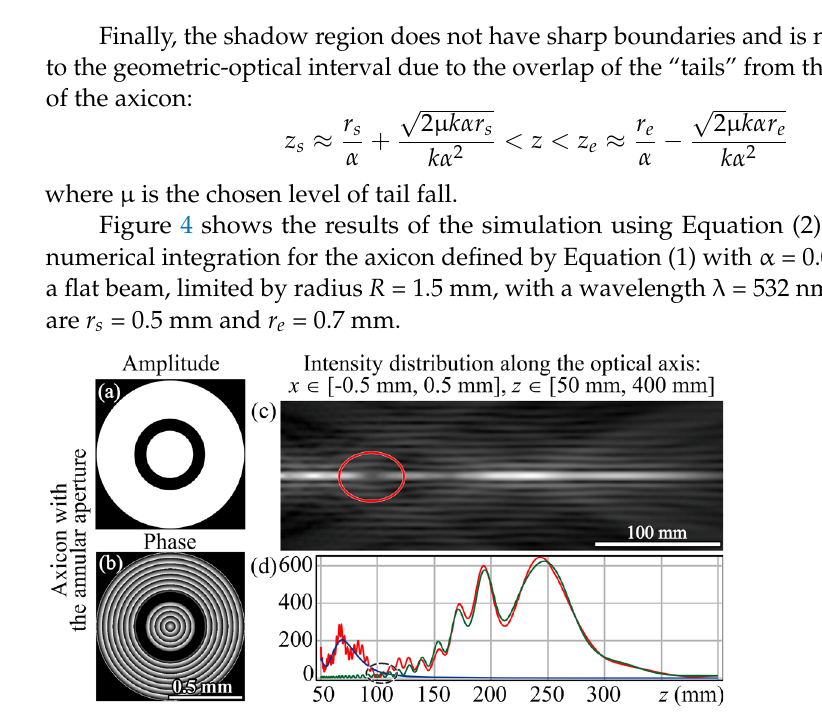
Figure 4. Simulation results of the optical bottle formation by blocking radiation using an annular screen under illumination with a flat beam: ( a ) amplitude and ( b ) phase at the input, ( c ) amplitude distribution along the optical axis ( x ∈ [ − 0.5 mm; 0.5 mm], z ∈ [50 mm; 400 mm]), ( d ) plot of intensity on the axis for the annular slots r s = 0, r e = 0.5 mm (blue color), r s = 0.7 mm, r e = 1.5 mm (green color) and for the blocking screen r s = 0.5 mm, r e = 0.7 mm (red color).